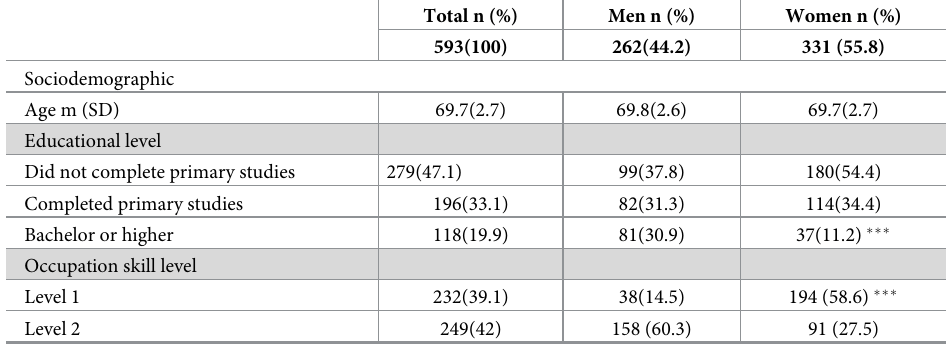
Table 1. Characteristics of the sample according to